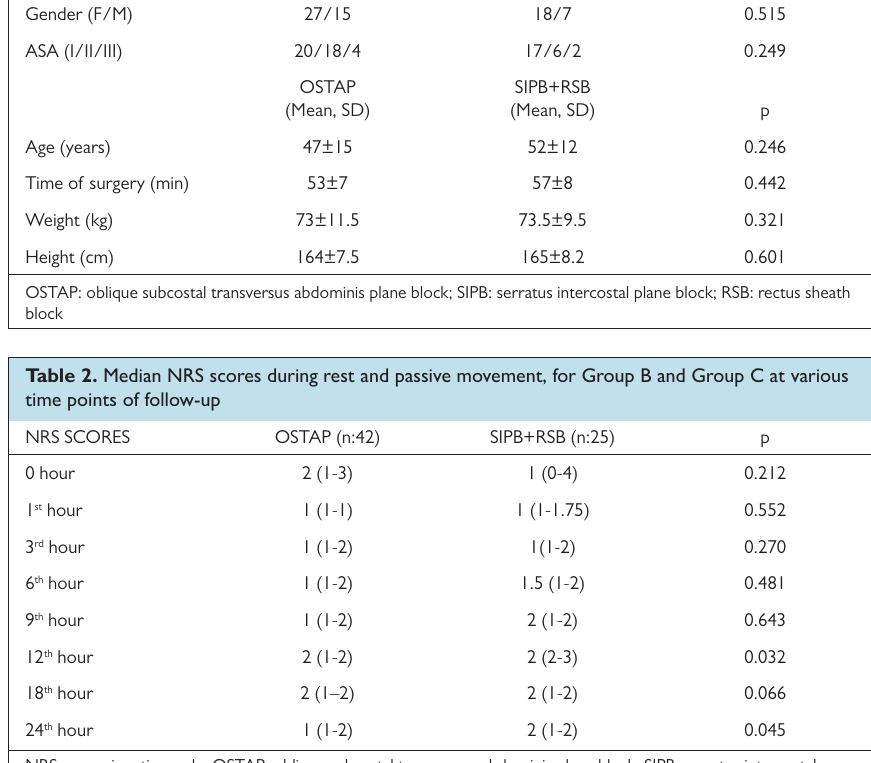
NRS: numeric rating scale; OSTAP: oblique subcostal transversus abdominis plane block; SIPB: serratus intercostal plane block; RSB: rectus sheath block Data are expressed as median (percentiles 25-75). Table 3. Comparison of analgesia requirements between the groups for the first 24 postoperative